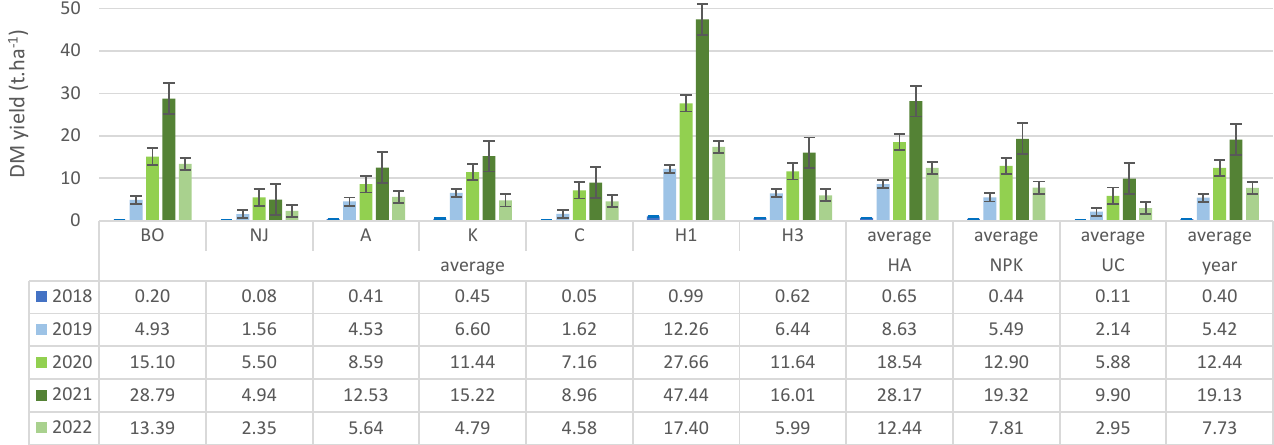
Figure 2. The dry matter yields according to cultivars and treatments. Average data with standard deviation are added.